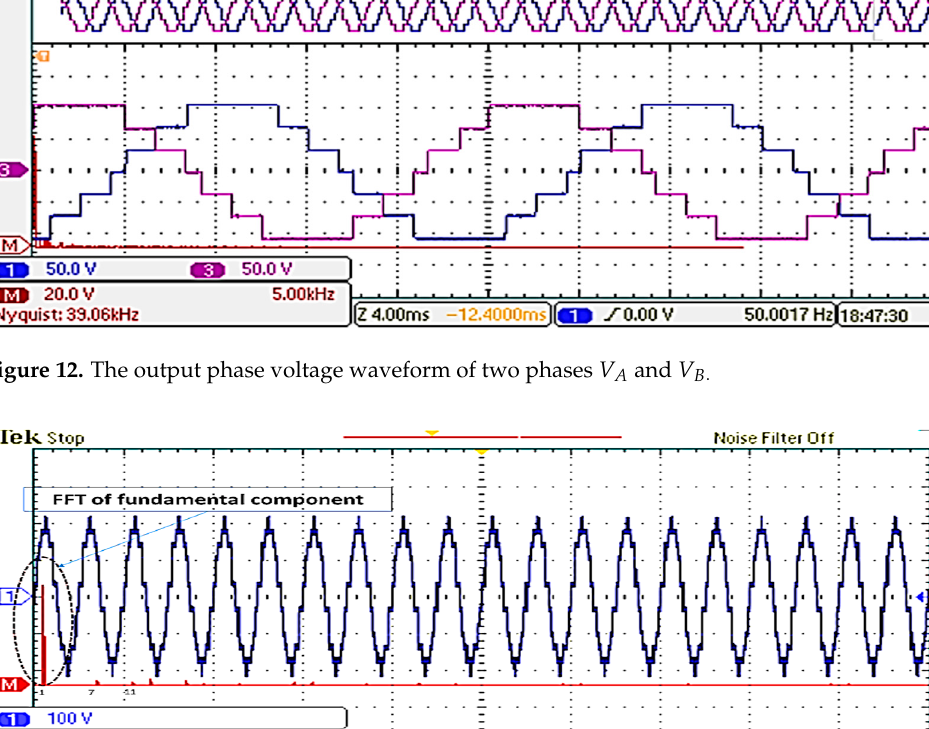
Figure 13. Line-line voltage ( V AB ) and its harmonic spectrum in red color for no load condition ( M i = 0.8).